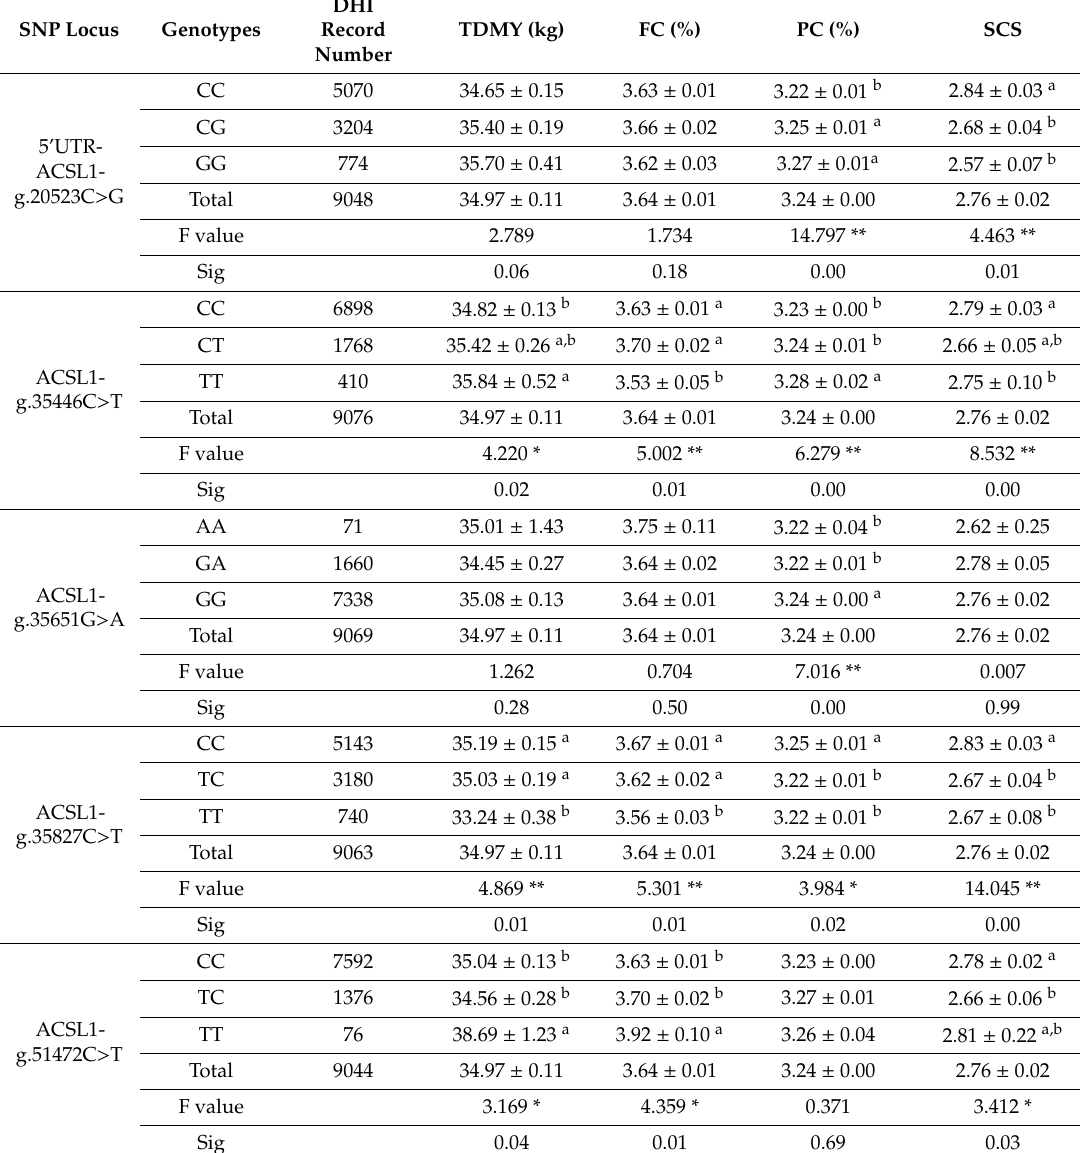
Table 5. E ff ects of SNPs in ACSL1 genes on milk production traits and